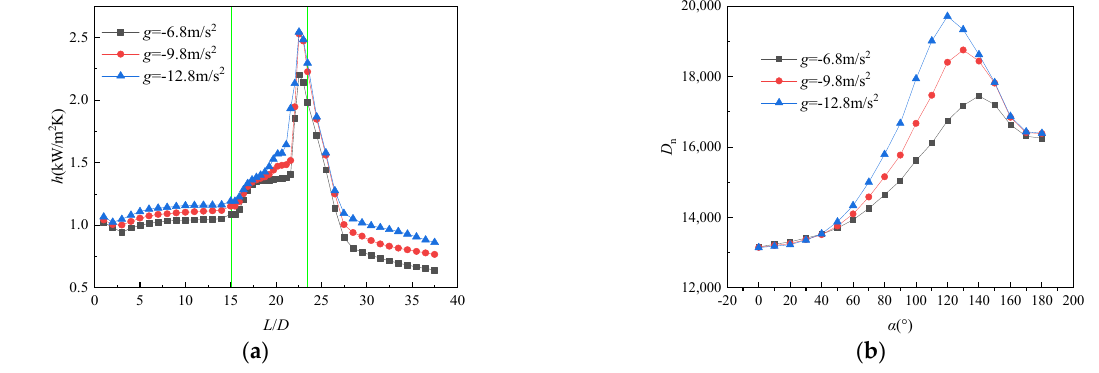
Figure 12. The changes in h with L / D and in Dn with α under different gravity conditions: ( a ) L/D , ( b ) α (°). According to Figure 12a, since gravity increases from − 12.8 m/s 2 to − 6.8 m/s 2 , the peak